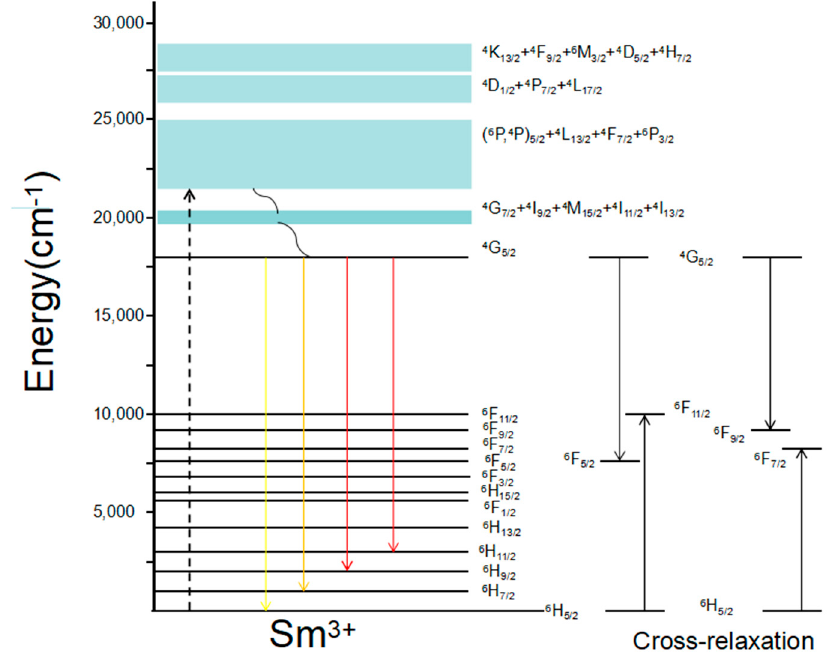
Figure 5. Simply energy levels diagram of Sm 3+ ions in LN single crystals showing excitation and emission processes.